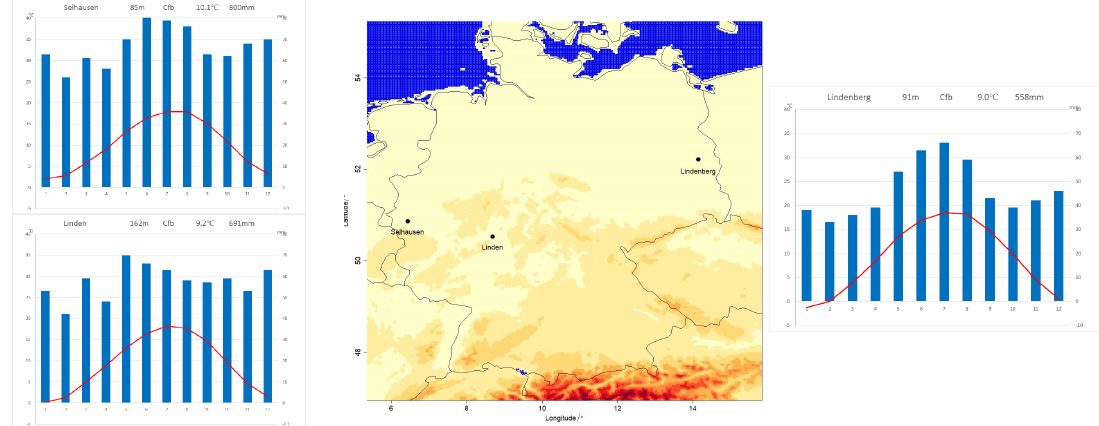
Figure 1. Map ( center ) with the three experimental locations (Lindenberg, Linden, and Selhausen) surrounded by their (Selhausen— topleft , Linden— bottomleft , Lindenberg— right ) climate diagrams (data from Reference [42], 1982–2012), where the monthly precipitation sums are marked with blue bars and the annual cycle of monthly mean temperatures is shown in